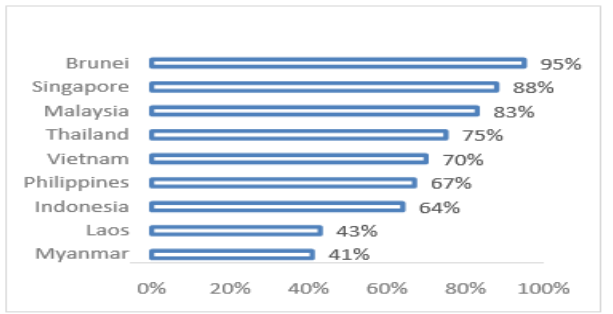
Figure 1. Internet penetration (%) in Southeast Asia Countries [17].